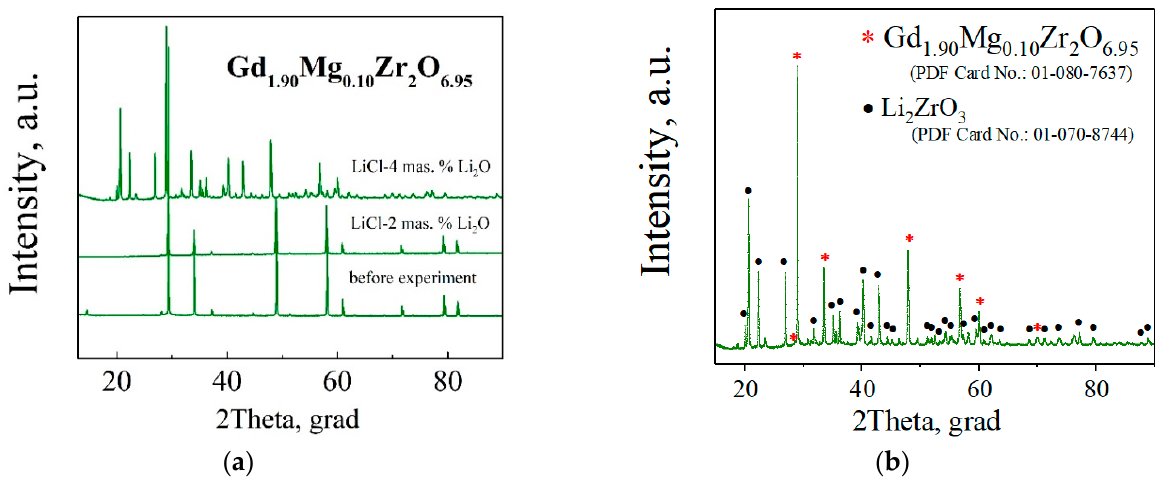
Figure 9. XRD patterns of the sample Gd 1.90 Mg 0.10 Zr 2 O 6.95 before the melt holding experiment (PDF